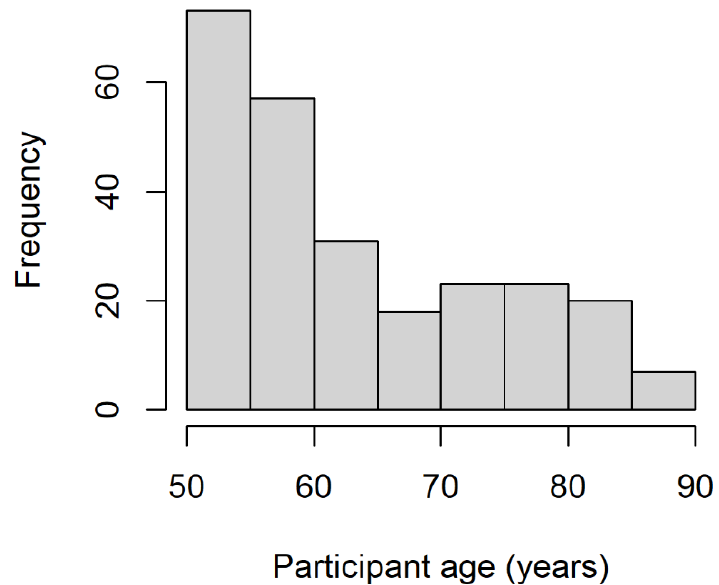
Figure 2. Frequency plot of the participants’ ages. Each bar represents the number of participants in each age group (5 years).